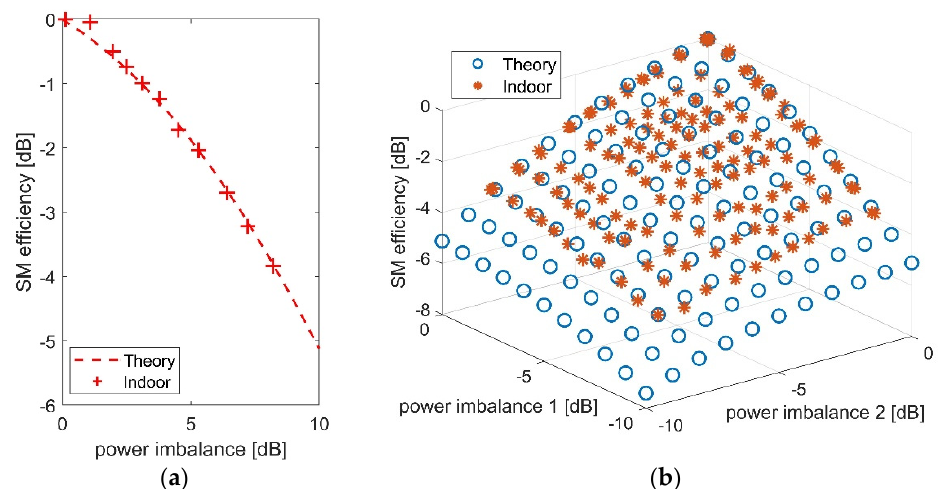
Figure 3. SM efficiency (considering only power imbalances) in the indoor scenario. ( a ) Power imbalance is introduced by reducing the efficiency of one element; ( b ) power imbalances are introduced by reducing the efficiencies of two elements to different values.